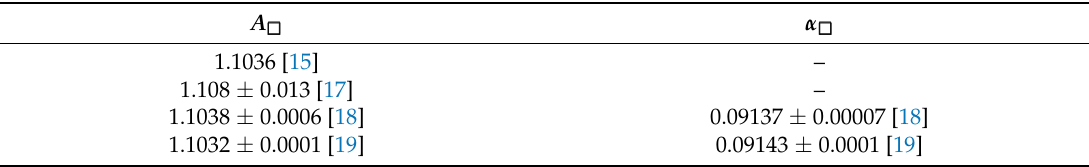
Table 1. Prefactors of the Odijk deflection length